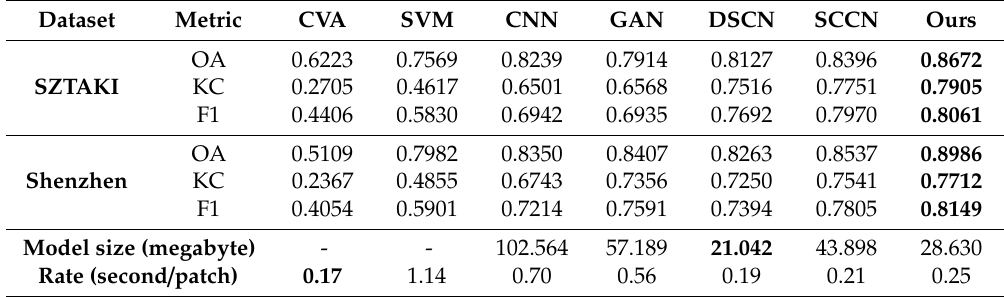
Table 3. Overall accuracy, Kappa coefficients and F1 score over state-of-the-art methods on SZTAKI and Shenzhen datasets, and the size and processing rate of their models. The best values are in bold.